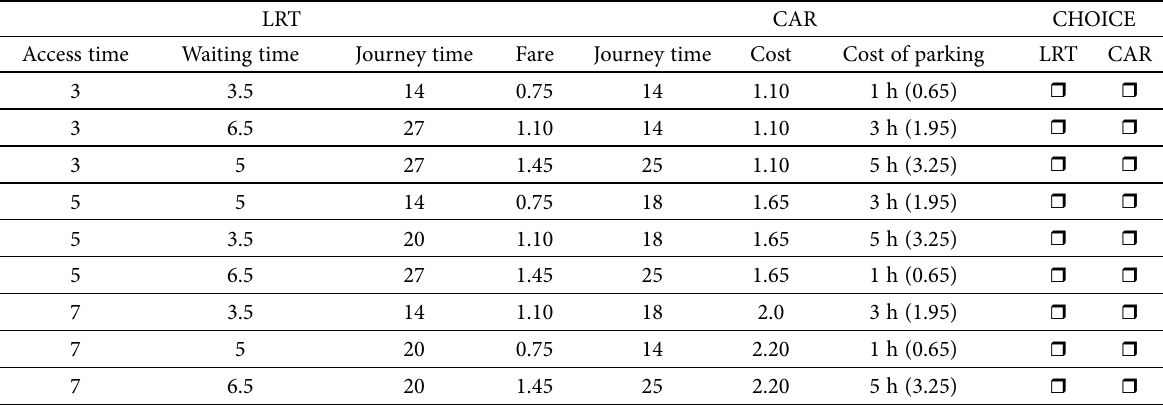
Table 4. Form and results for the survey LRT vs.